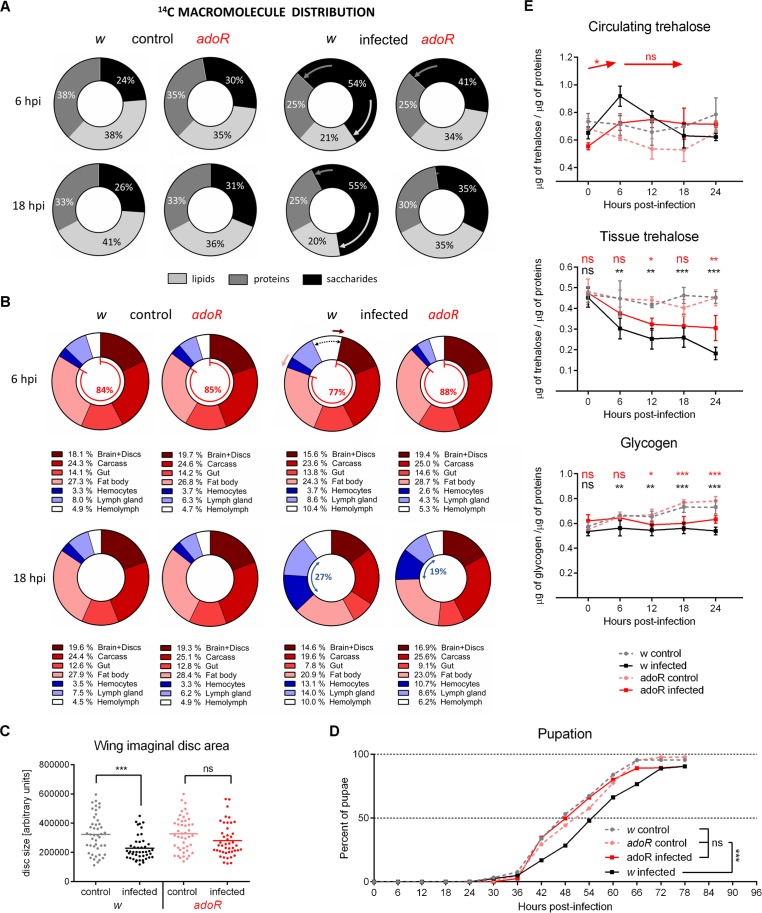
Metabolic changes and developmental effects of AdoR deficiency.(A) Incorporation of 14C-glucose into lipids and proteins is reduced upon infection in w but not in adoR larvae. Arrows indicate infection-induced changes. For statistical analysis, see S2 Fig. (B) Relative distribution of 14C in the hemolymph (white), immune cells (circulating hemocytes, dark blue; lymph gland, light blue), and the remaining body parts (brain with imaginal discs—brown; carcass, i.e., all the remnants after dissecting all other presented tissues—red; gut—light red; fat body—pink). Arrows indicate increasing 14C in hemolymph (black dashed arrow) of w at 6 hpi at the expense of brain+discs (brown arrow) and fat body (pink arrow); these changes are missing in adoR. Increase in hemolymph and in immune cells (blue arrow) of w at 18 hpi at the expense of all other tissues is smaller in adoR (less in immune cells and more in the rest). Legends below graphs show percentages in body parts. For detailed analysis, see S9 Fig and S10 Fig. (C) Growth of the wing imaginal discs is delayed by infection in w (unpaired t test p < 0.0001) but not in adoR larvae (p = 0.06). Each dot represents measured area of an individual disc at 18 hpi; horizontal lines indicate mean. (D) Pupation is delayed upon infection in w larvae (n = 316, control and 344, infected) but not in adoR larvae (n = 310, control and 293, infected). The rates were compared using Log-rank survival analysis; the p values are: w < 0.0001; adoR = 0.74; w control versus adoR control = 0.053; w control versus adoR infected = 0.054. (E) Nutrient contents in the hemolymph and whole larval lysates. Values are mean ± SEM of four experiments. Circulating trehalose in adoR does not form the 6 hpi peak of w; arrows show increase and no change (ns), respectively, when levels of infected adoR are compared between time points. Tissue trehalose show smaller differences for adoR and glycogen shows similar pattern to w. Asterisks show statistical significance when compared between infected and control animals at indicated time points (black for w, red for adoR). Tested by two-way ANOVA; for statistical analysis, see S2 Fig.